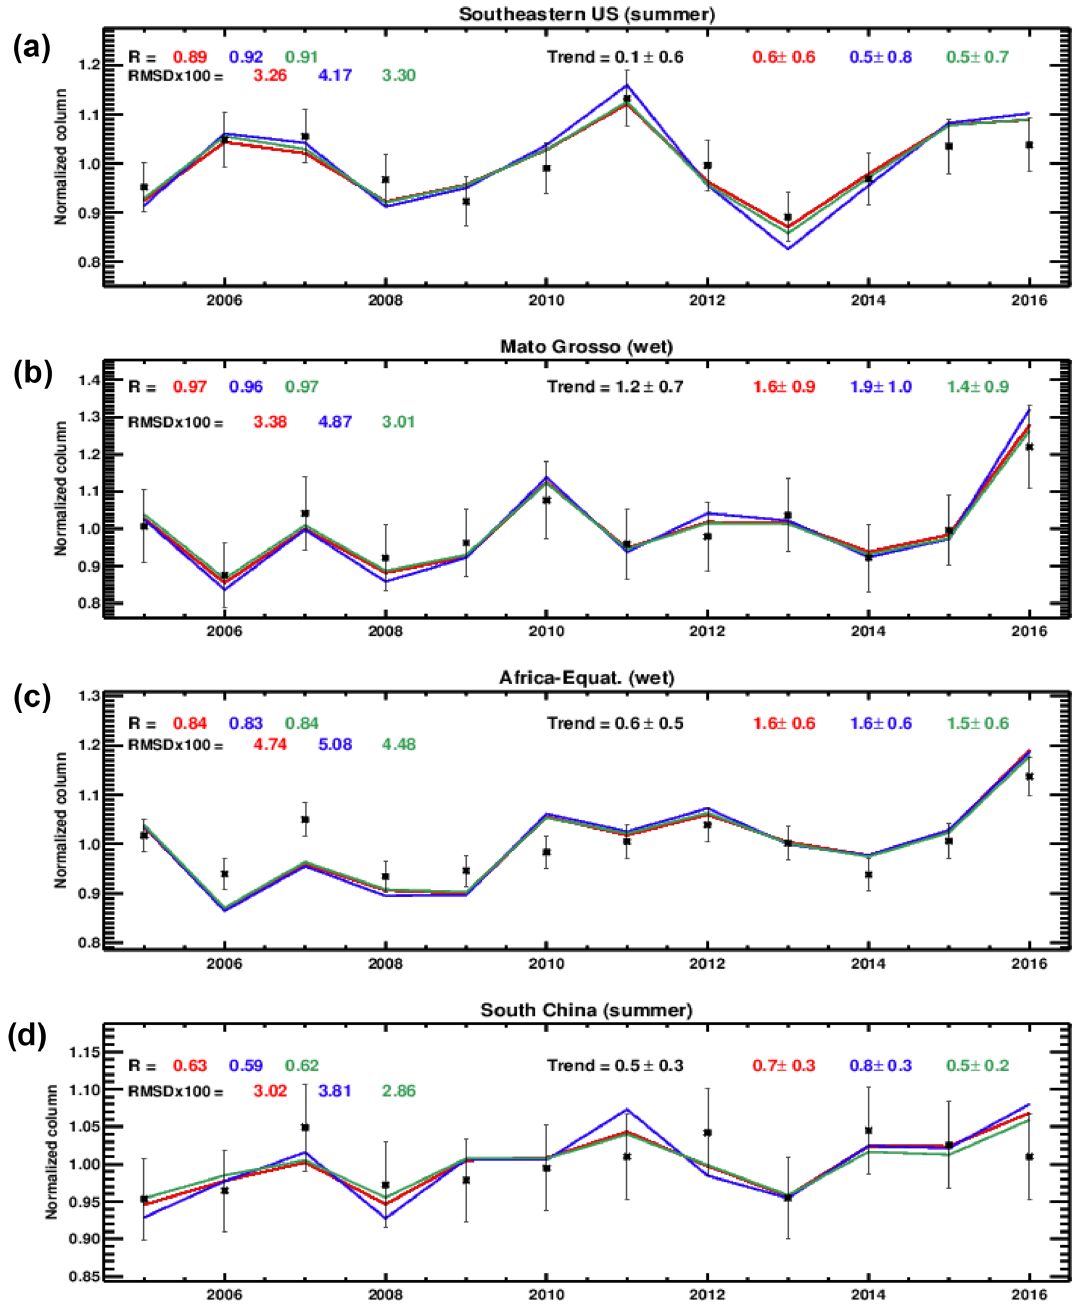
Figure 9. Interannual variability in seasonally averaged HCHO columns normalized by their 2005–2016 average over selected regions: (a) southeastern US, (b) Mato Grosso, (c) equatorial Africa, and (d) South China as defined in Fig. S9. The seasonal averages are cal- culated over June–August in the Northern Hemisphere and over the wet season (February–April) at Southern latitudes. Normalized OMI HCHO columns are represented by symbols with their 1 σ uncertainty bars; model results are shown as solid lines: runs A (red), B (blue), and C (green). The correlation coefficients ( R ), root-mean-square deviations (RMSDs) multiplied by 100, and trends (in %yr − 1 ) with 1 σ uncertainty estimates are given